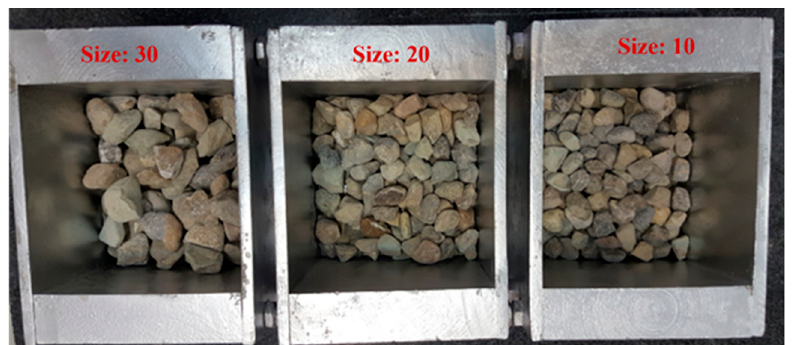
Figure 2. Various sizes of aggregates used in the present research based on the BS EN 13043 standard. Table 1. Initial neural network